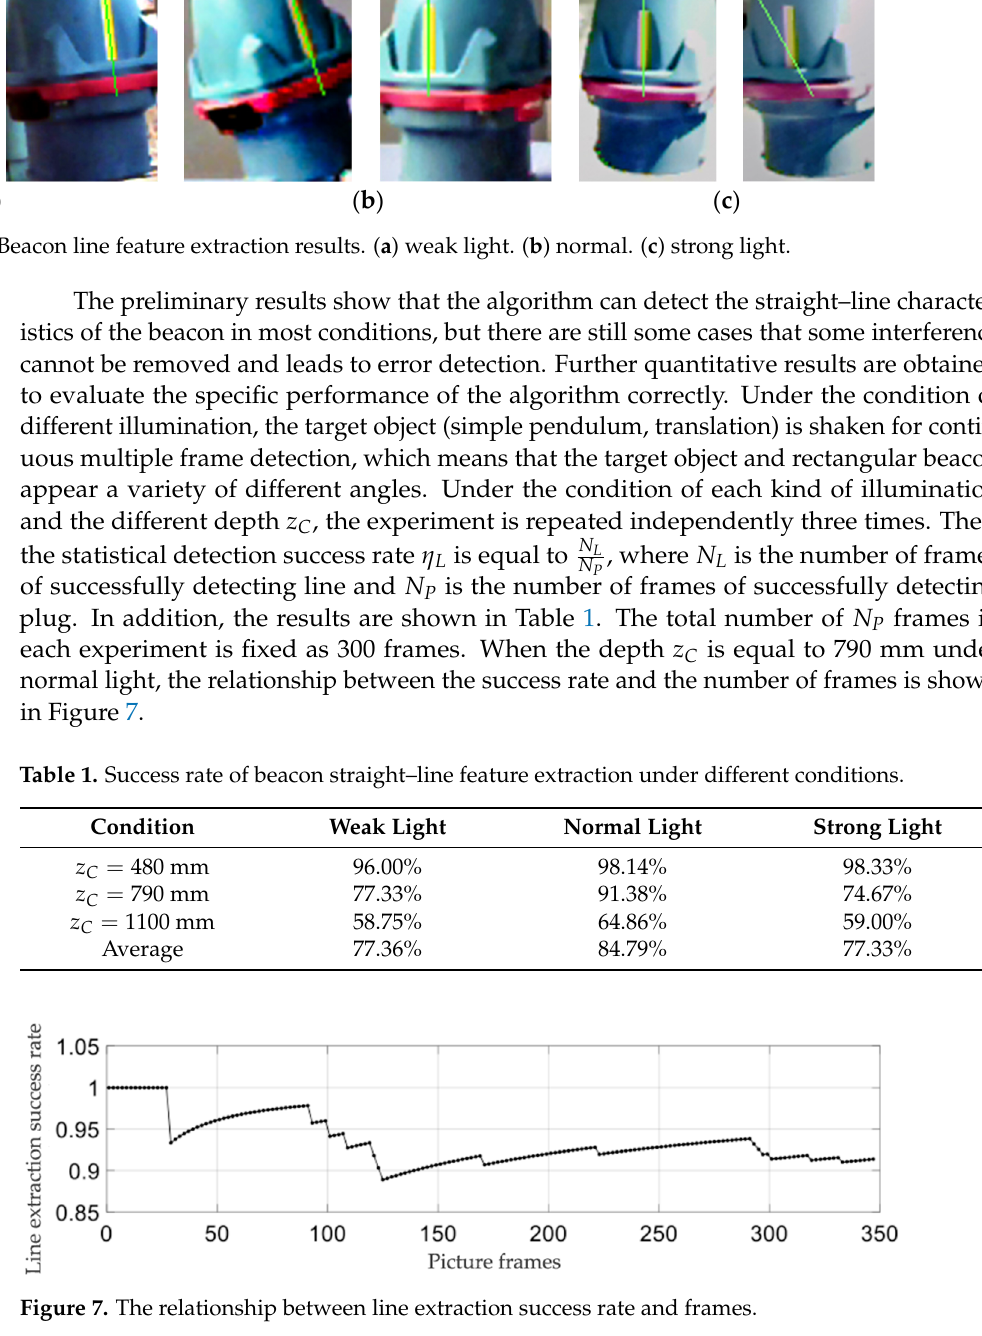
Figure 6. Beacon line feature extraction results. ( a ) weak light. ( b ) normal. ( c ) strong light.